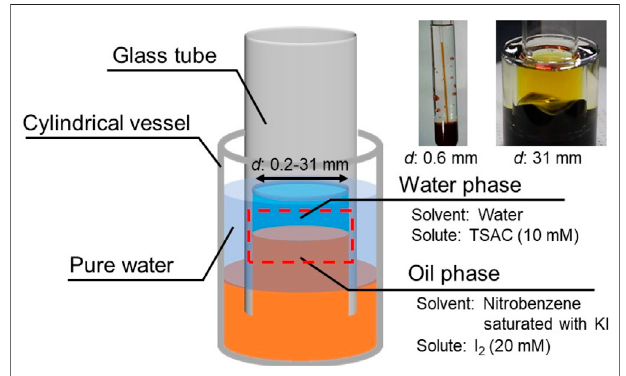
FIGURE 1 | Experimental setup for observation of oil/water contact line